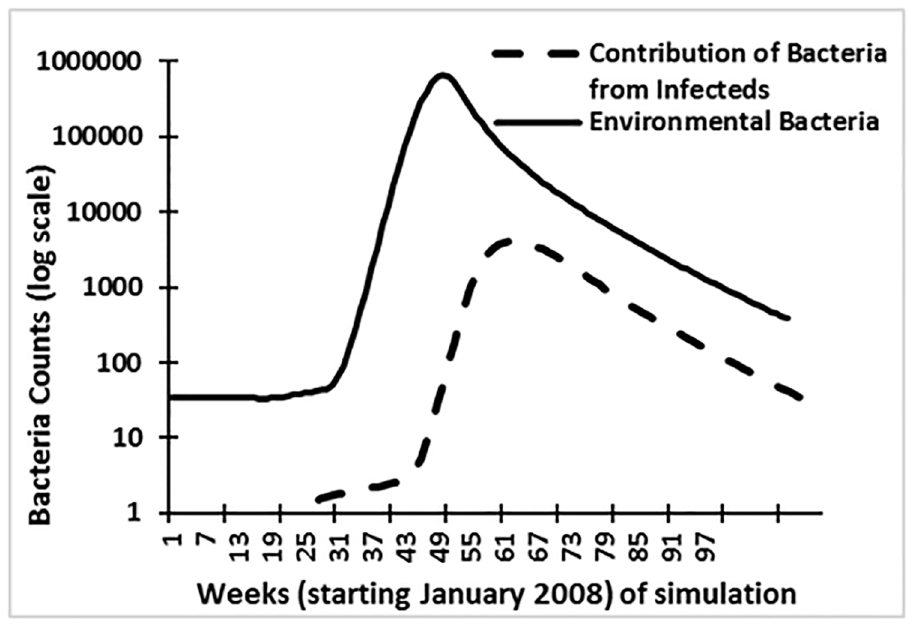
Fig 9. Simulated contribution of bacteria from infected population and growth of environmental bacteria.